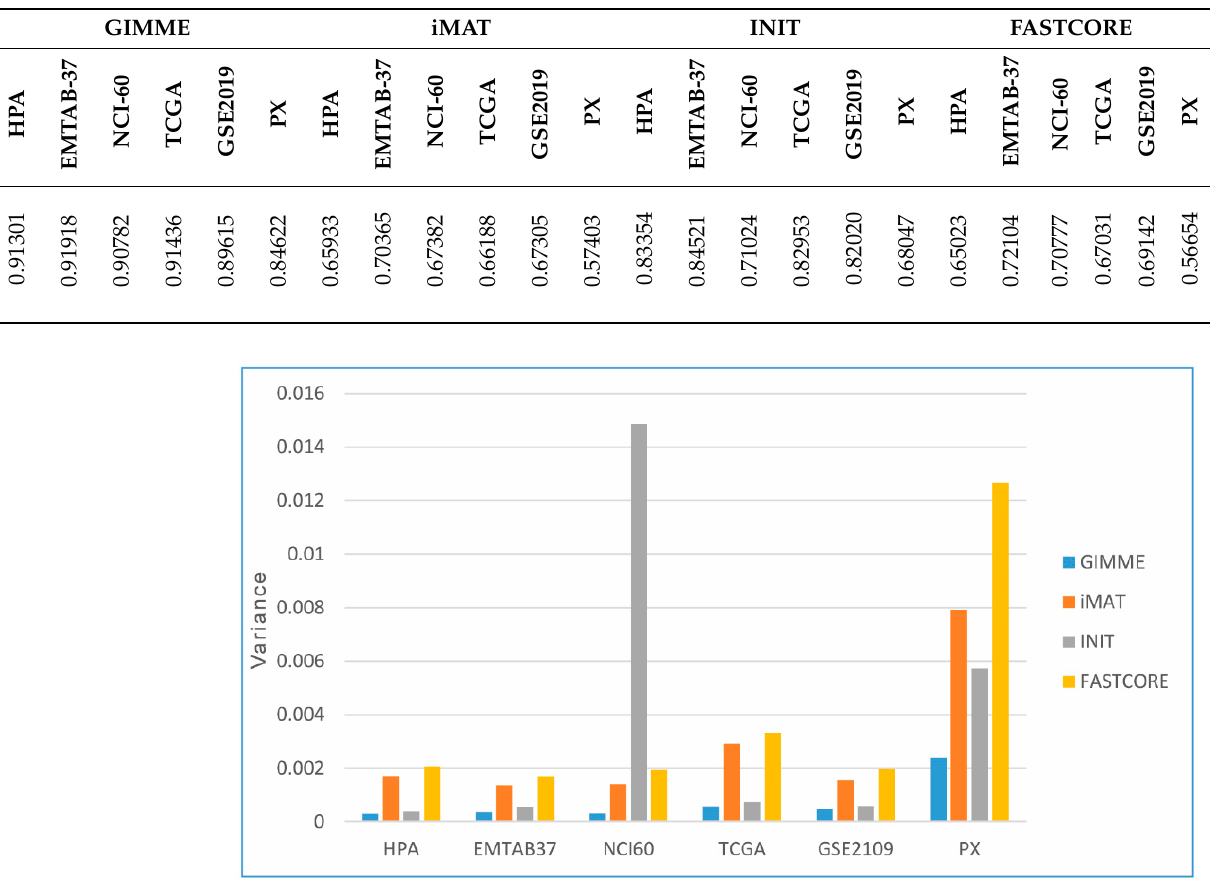
Figure 4. The Jaccard index variance distribution in all CGEMs. Proteome-based CGEMs show the highest variance distribution of active reactions.